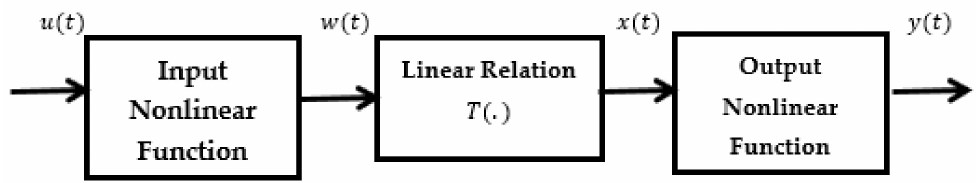
Figure 3. Generalized structure of HW